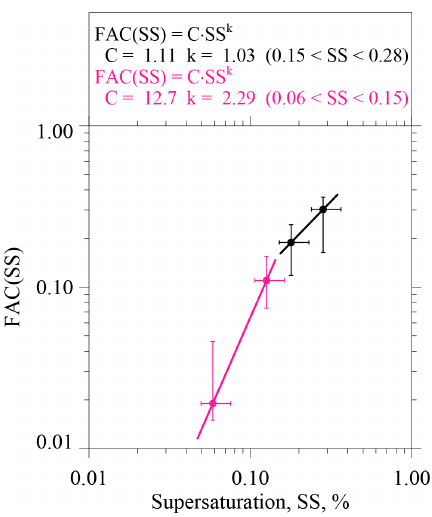
Figure 8. Parameterized CCN activity spectrum derived using CPC and UHSAS measurements from the 20 onshore trajectories that arrived at the Arauco site between 29 May and 28 June 2015. Pink circles and the pink fit line are for lower-limit diameters set at 0.200 and 0.120µm. Black circles and the black fit line are for lower-limit diameters set at 0.095 and 0.070µm. Figure legend has power-law coefficients describing the parameterization; i.e., how FAC varies with SS.